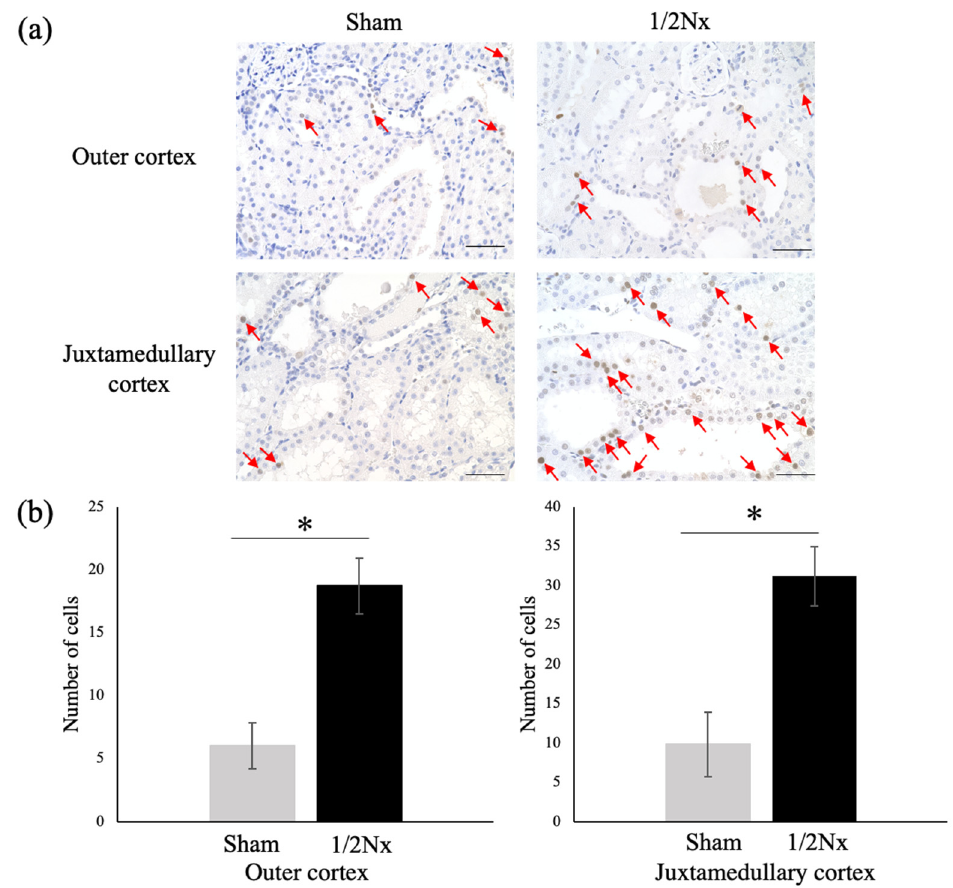
Figure 6. Immunohistochemical analysis of proliferation activity in the renal tubules in Sham oper- ated and 1/2Nx DEK rats 84 days after surgery. ( a ) Immunohistochemistry of PCNA in the outer and juxtamedullary cortices. Typical PCNA-positive cells are indicated by red arrows. Scale bar = 50 µ m. ( b ) Numbers of PCNA-positive cells per unit area. n = 3 with at least three randomly selected sections in each area analyzed in each group. * p < 0.05 between the two groups.